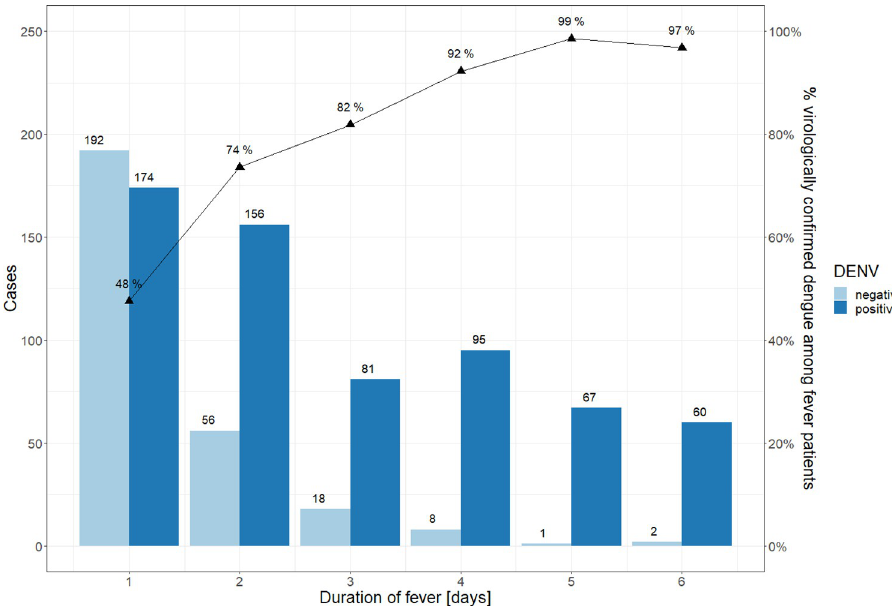
Fig 3. The number of children (N = 910) in the IDAMS study with positive and negative dengue diagnosis among discrete non-overlapping sub-cohorts with exact number of persisting fever days.